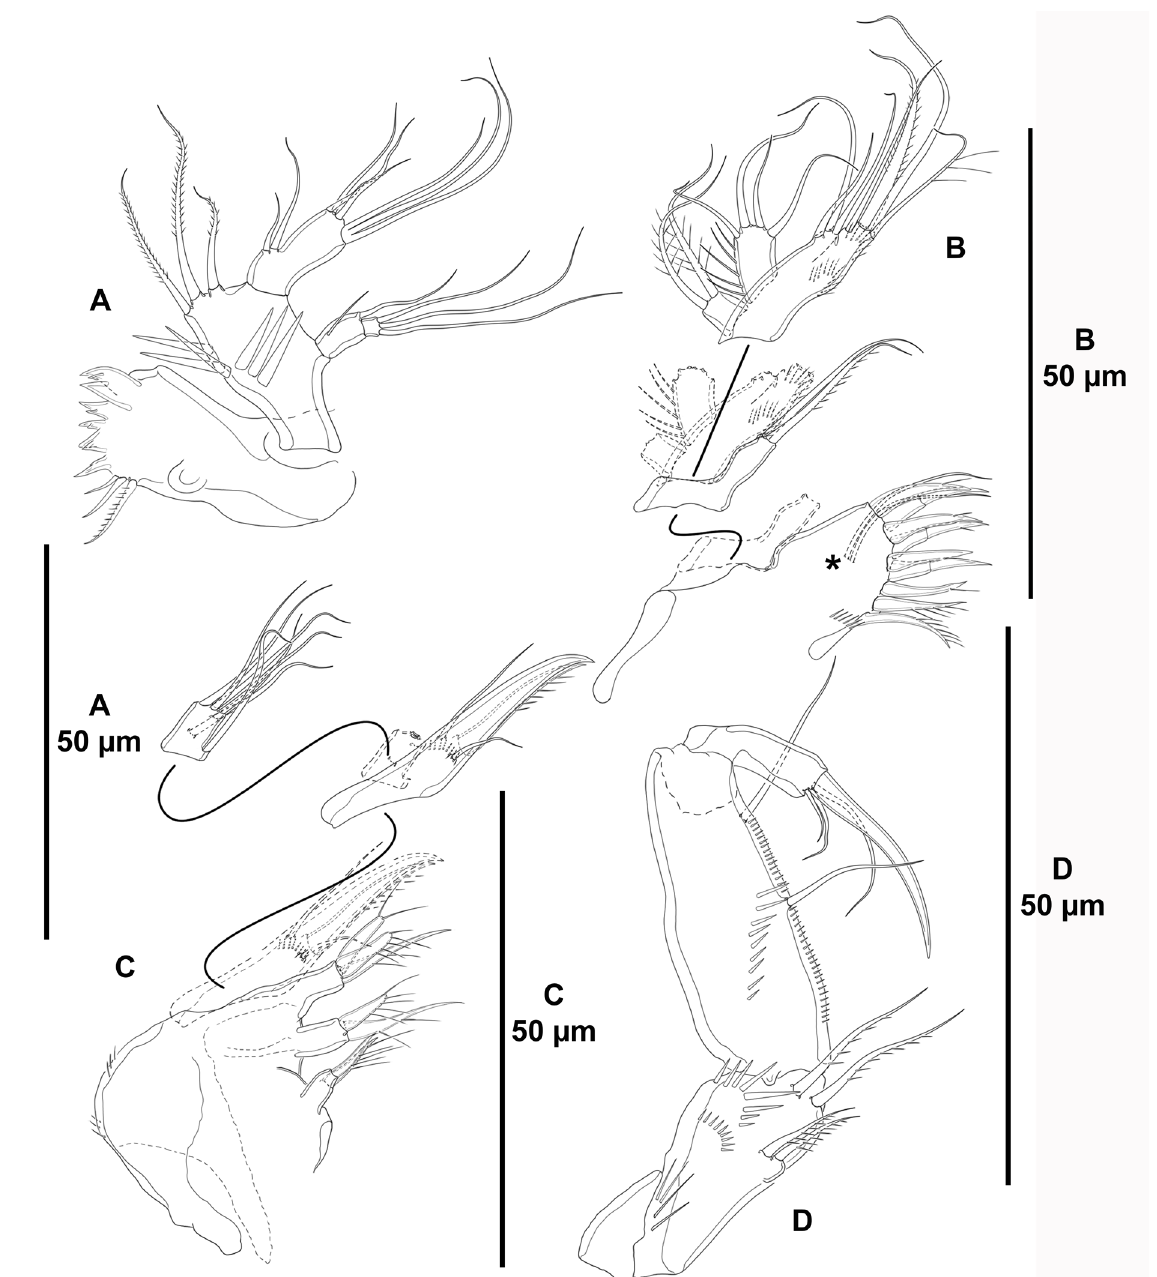
Fig. 14. Spinodiosaccus primus gen. et sp. nov., paratype, ♀ (ICML-EMUCOP-180119-64). A . Mandible. B . Maxillule (asterisk indicates two surface setae). C . Maxilla. D .